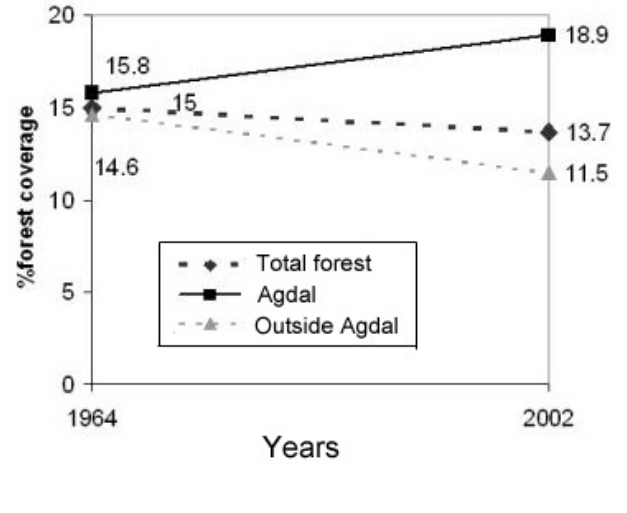
Fig. 5 . Patterns of change in the mean tree coverage according to customary status ( Agdal / outside Agdal ) between 1964 and 2002 (adapted from Hammi et al. 2010).